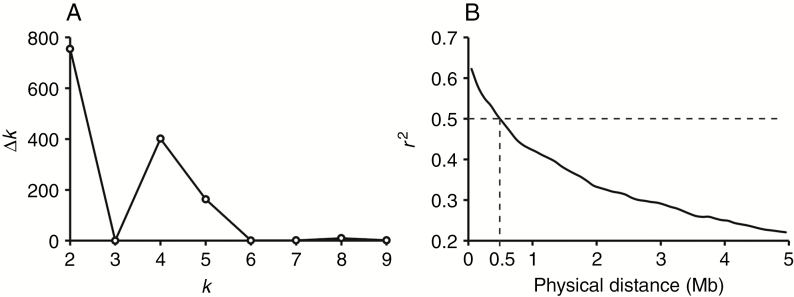
Population structure and linkage disequilibrium (LD) analysis. (A) Plot of Δk against putative k ranging from 2 to 9. (B) Decay of LD for the whole genome; horizontal and vertical dashed lines indicates that LD declined to 0.5 at about 0.5 Mb.